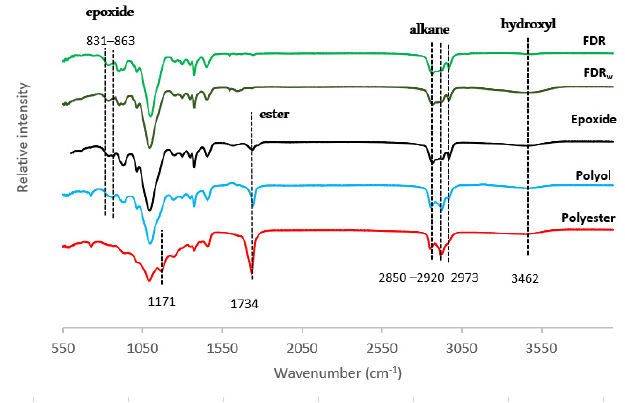
Figure 2. FTIR spectra. Structural evolution from FDR w to polyester.